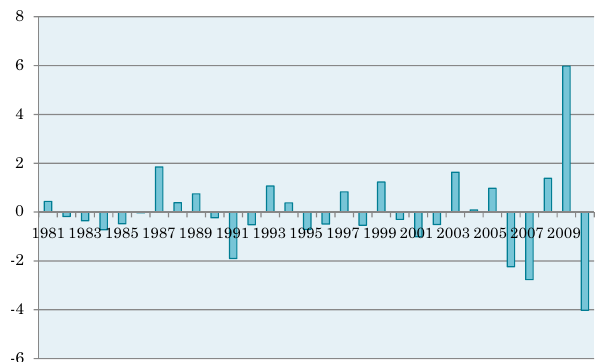
Fig. 10. Office sales receipts as percentage of capital value – deviations from the HP filter trend ( λ = 6.25)